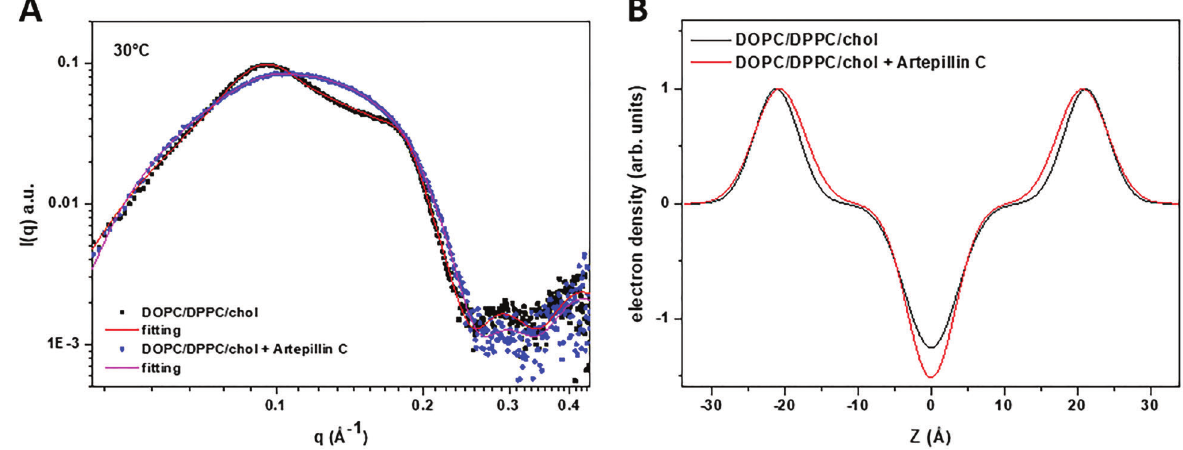
Figure 2. Small angle X-ray scattering (SAXS) diagrams ( A ) and electron density pro fi les ( B ) of extruded lipid vesicles formed of DOPC/ DPPC/cholesterol (23:47:30 molar ratio), 40 mM, in the absence and presence of 10 mol% of artepillin C, obtained at 30°C. Electron density pro fi les were obtained by fi tting the SAXS curves with the aid of the Global Analysis Program software (version 1.3). Table 2. Structural parameters obtained by fi tting the small angle X-ray scattering pro fi les of extruded vesicles formed of DOPC/DPPC/cholesterol (23:47:30 molar ratio), 40 mM, in the absence and presence of 10 mol% artepillin C, at